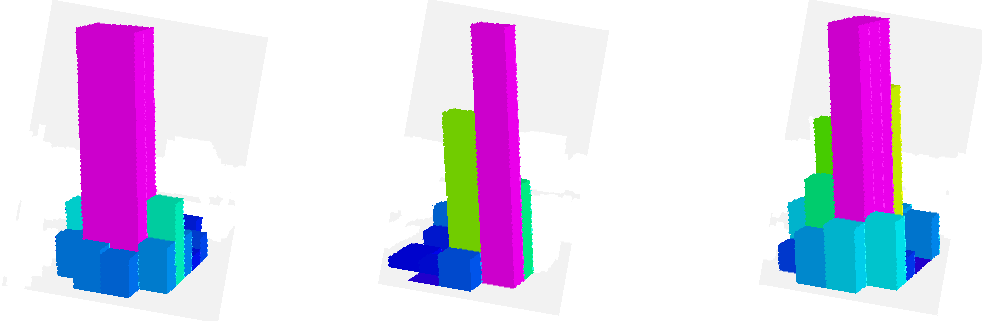
Figure 6. Distribution of the pressure measurements registered by the arrays of tactile sensors of the three fingers in an intermediate iteration during the manipulation task (first task).